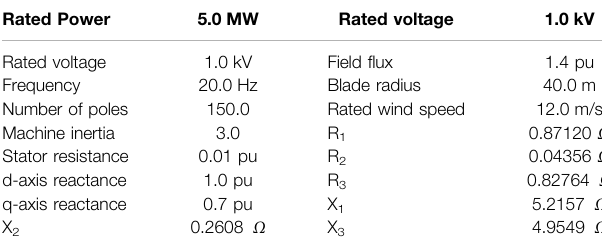
TABLE 1 | Parameters of the model system.